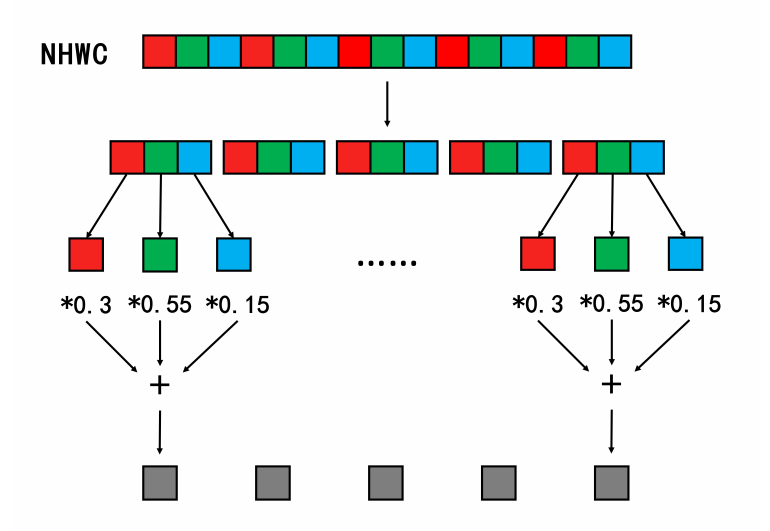
Figure 8. Calculation of grayscale in NHWC